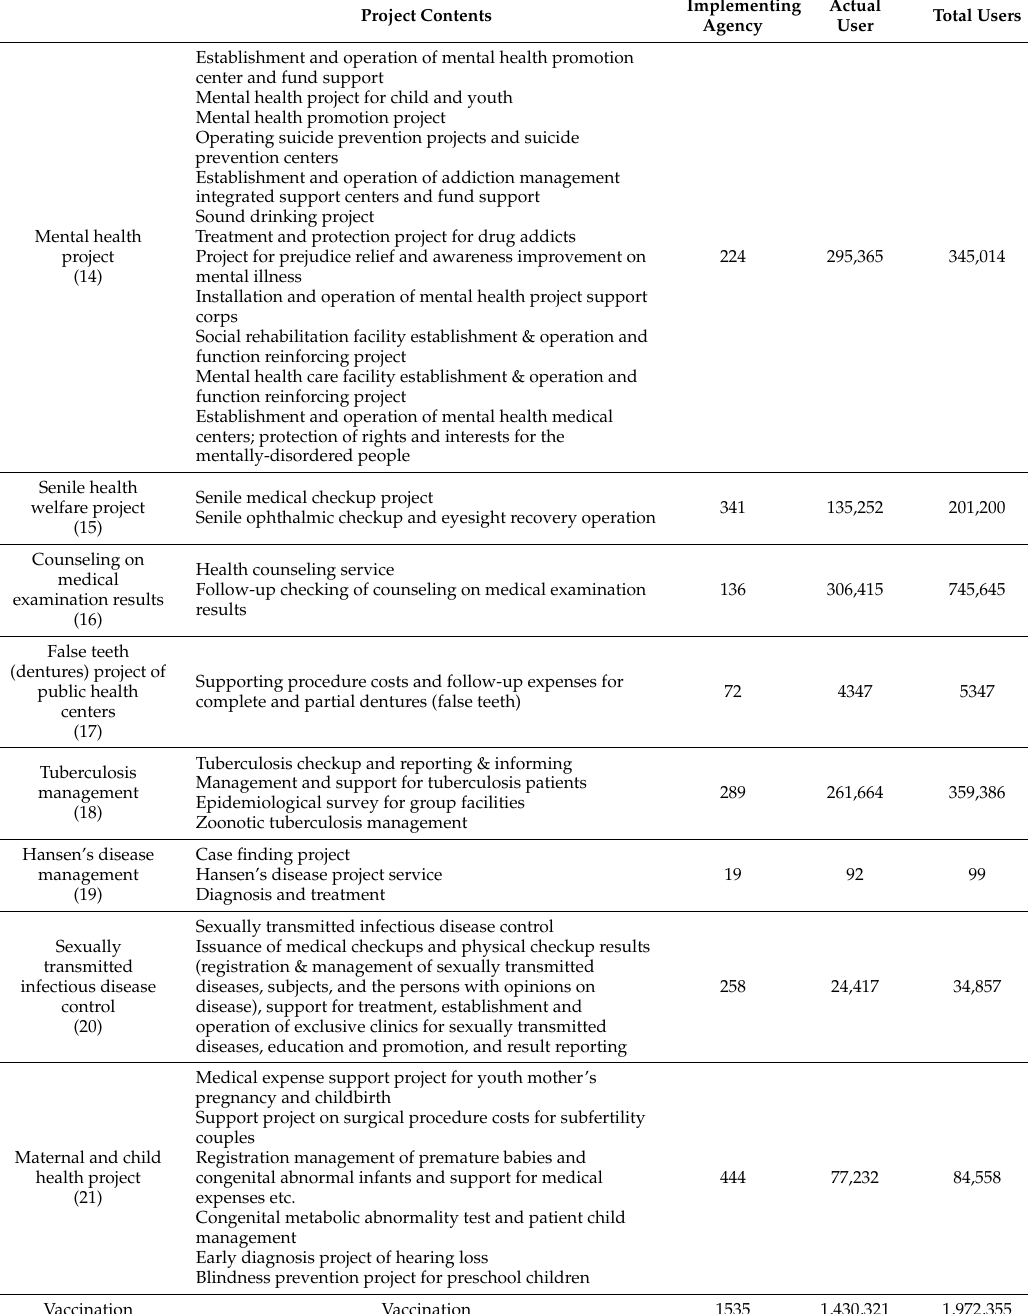
Table 3. Projects other than community integrated health